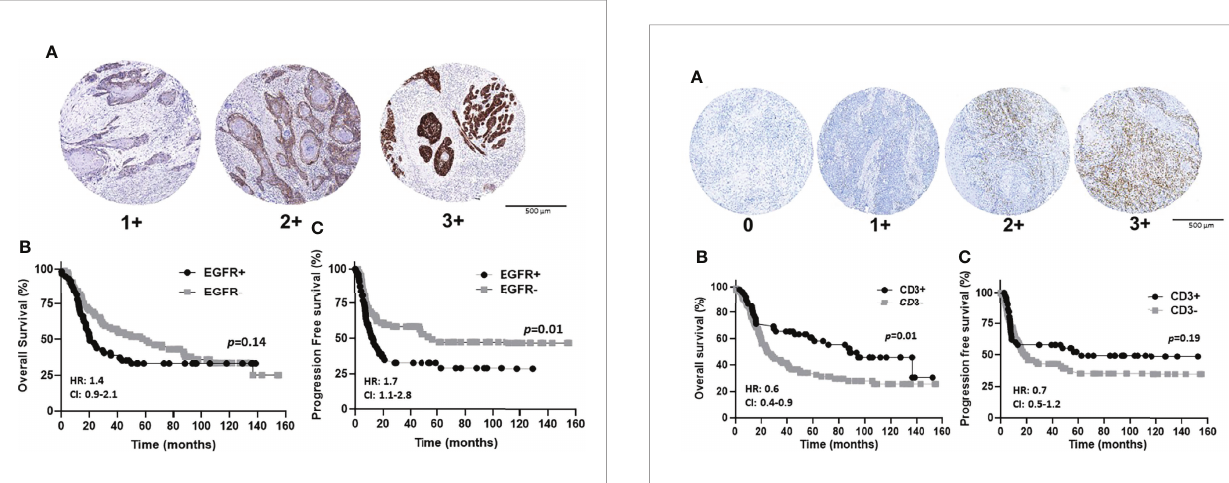
FIGURE 4 | CD3 immunostaining and expression scores in OSCCs. (A) : Shown are images of no [0], low [1+], moderate [2+], and strong [3+] CD3 expression scores. (B, C) : Shown are Kaplan-Meier estimates of the overall survival (B) and progression free survival (C) of CD3+ (2+ and 3+) and CD3- (0 and 1+) patients. HR, hazard ratio; CI: 95% con fi dence interval.